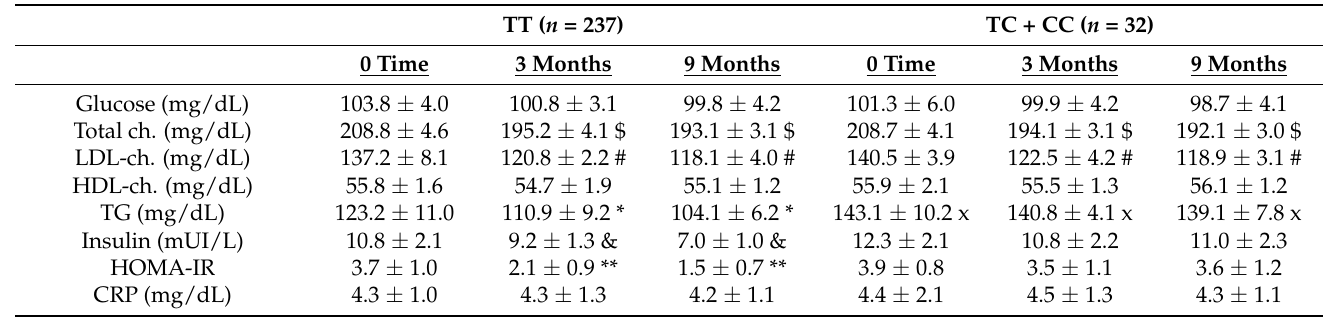
Table 3. Biochemical parameters at three times (basal and 3 and 9 months after the intervention) (mean ± SD).